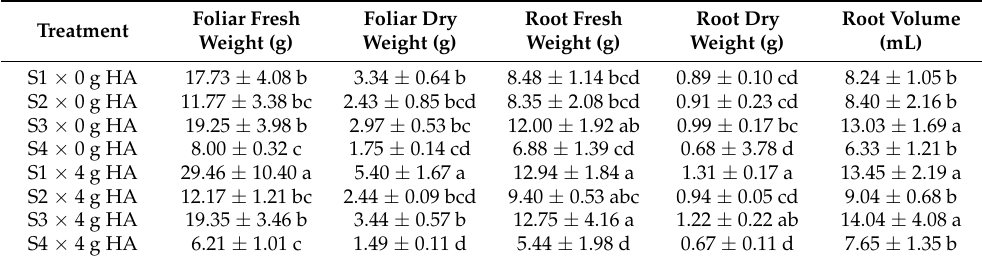
Table 5. Effect of substrate and humic acid on the biomass of strawberry ‘Aroma’ variety plants, during